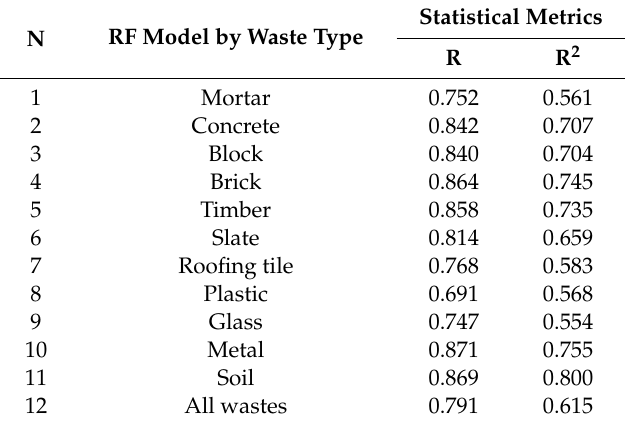
Table 3. Accuracy assessment of the RF